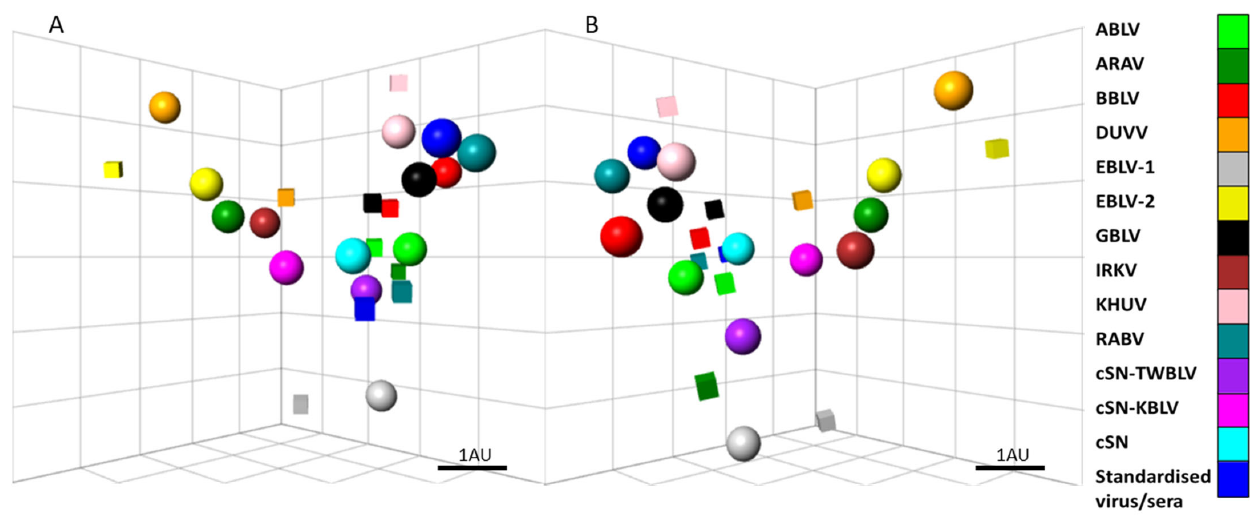
Figure 4. Three ‐ dimensional antigenic map of phylogroup I lyssavirus and sera. ( A ) Viruses (spheres) and sera (boxes) are positioned such that the distance from each serum to each virus is determined by the neutralization titre. With the exception of the standardized virus (CVS) and standardized sera (WOAH), which are coloured dark blue, each phylogroup I virus and available associated specific sera have been colour coded according to the strain used. Multidimensional scaling is used to position both sera and viruses relative to each other, so the orientation of the map within the axes is free. Scale bar shows one antigenic unit (AU). ( B ) The same antigenic map, rotated to a different orientation for clarity.